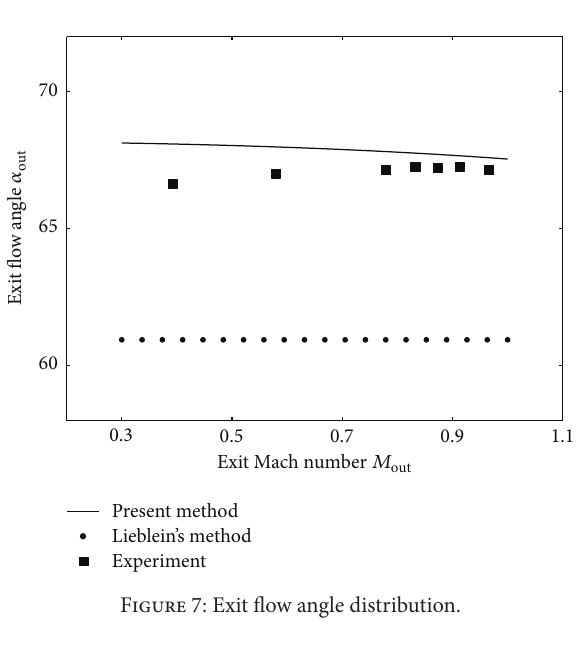
Figure 7: Exit flow angle distribution.